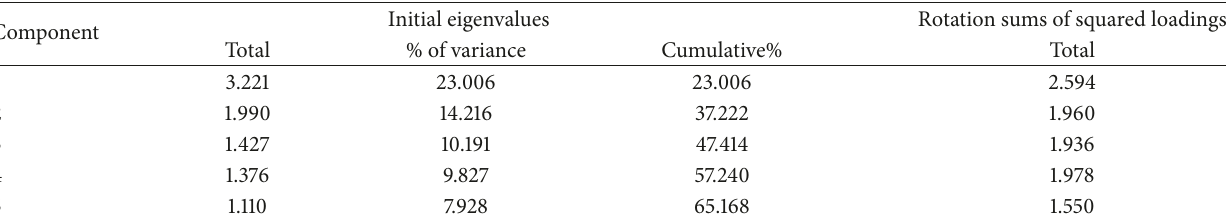
Table 3: Factor analysis knowledge domain: construct validity.